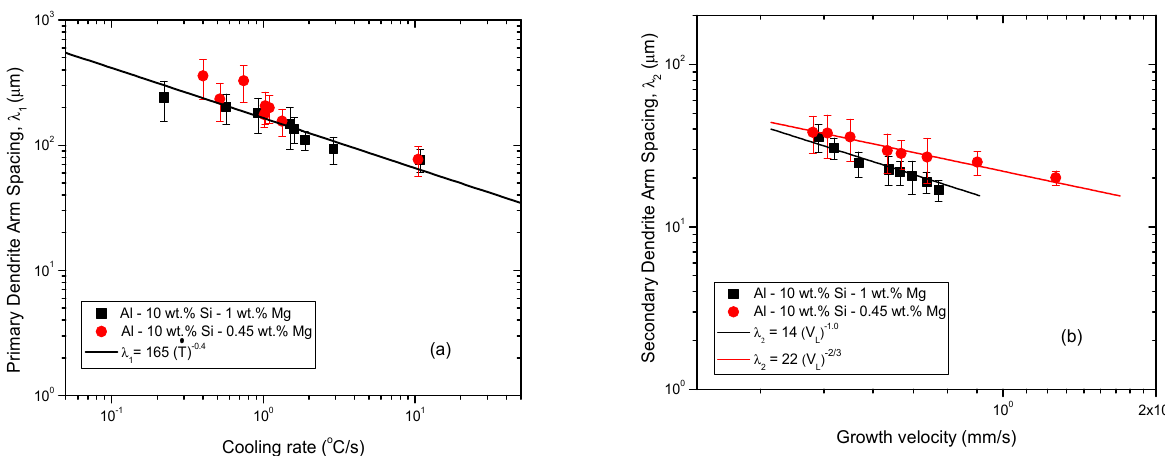
Figure 9. Scaling relations of microstructural spacings with thermal solidification parameters, such as ( a ) cooling rate and ( b ) growth velocity for the Al-Si(-Mg) alloys.